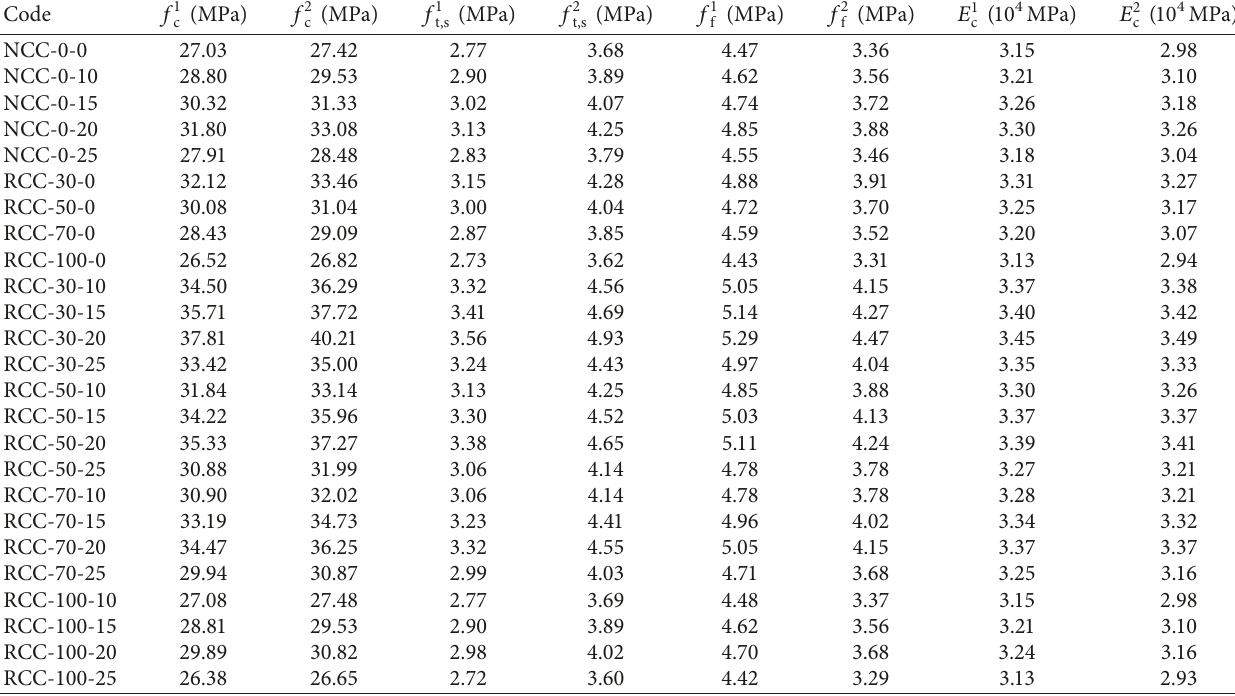
Figure 9: Microstructure of RCC-70-20 in the experimental group. Table 5: Calculation